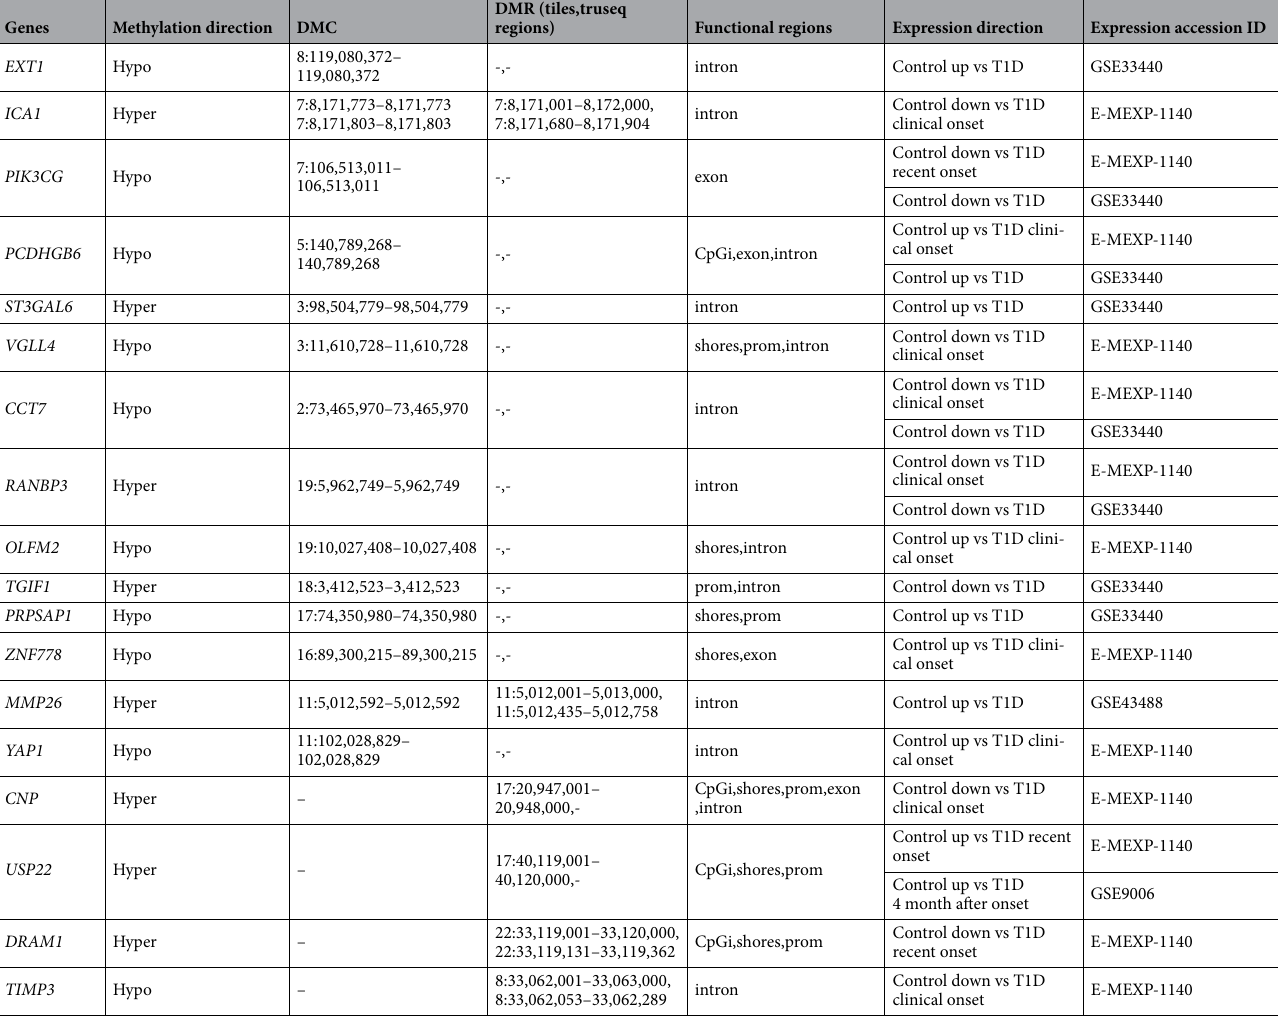
Table 2. Differentially methylated events across three familial T1D overlapped with differentially expressed genes of published T1D